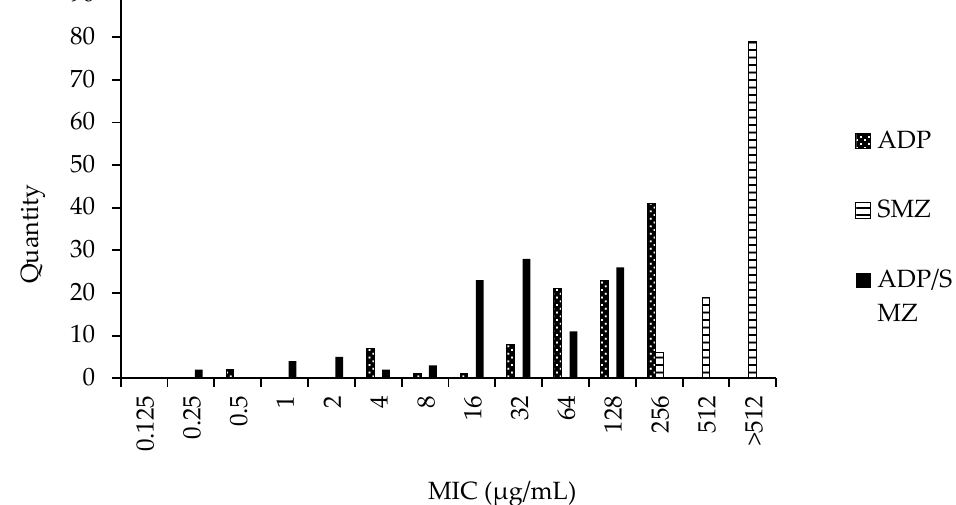
Figure 1. The MIC distribution of ADP, SMZ, and ADP/SMZ (MIC to ADP concentration) against 104 G. parasuis.